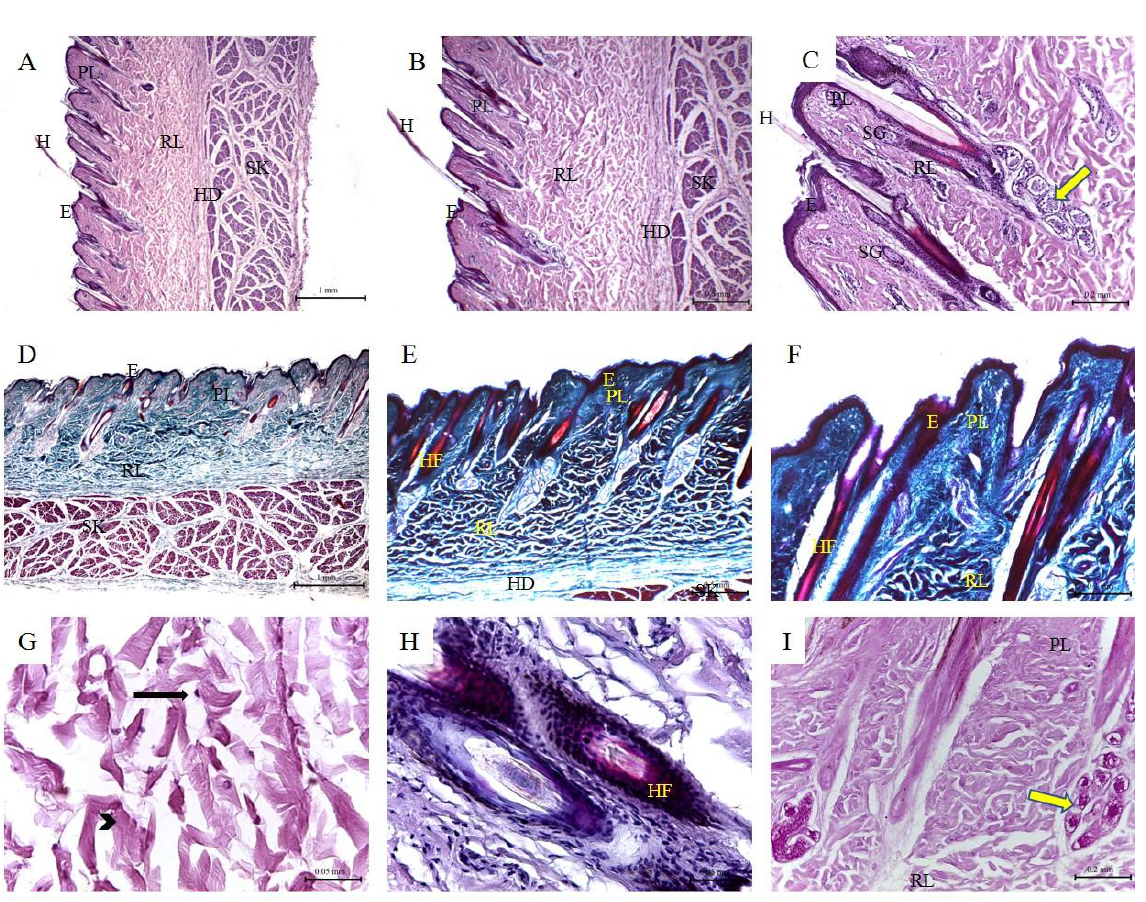
Figure 3: Histological features of camel skin . Hematoxylin and eosin staining ( A-C ; G-H) ; Cross- man's trichrome staining ( D-F) ; and PAS staining ( I ) of camel skin tissue sections. (E) Keratinized stratified squamous epithelium of the epidermis; (PL) Papillary layer of the dermis; (RL) Reticular layer of the dermis; (SG) Sebaceous glands; (Black arrow) fibrocytes; (Arrow heads) collagen bundles of the reticular layer; (Yellow arrow) Sweat glands; (HF) Hair follicles; (NT) Nervous tissue; (SK) Skeletal